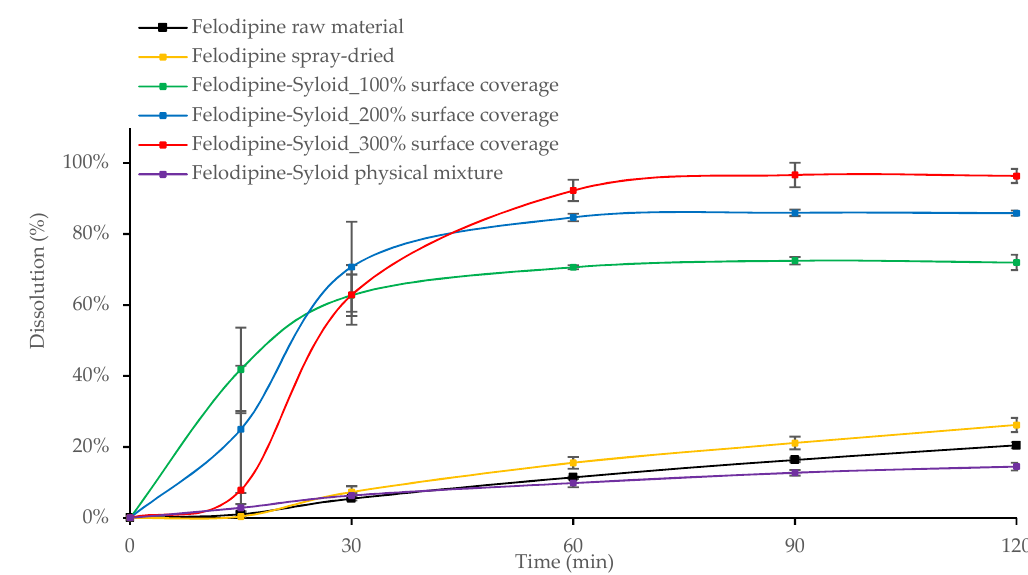
Figure 6. Release profiles of Felodipine raw and spray-dried materials, Felodipine-Syloid formulations at various drug loads, Felodipine-Syloid physical mixture. Testing conditions: phosphate bu ff er pH 6.5 + 0.25% SLS, 500 mL, USP apparatus 1, 50 rpm. The medium was adapted from a USP 36